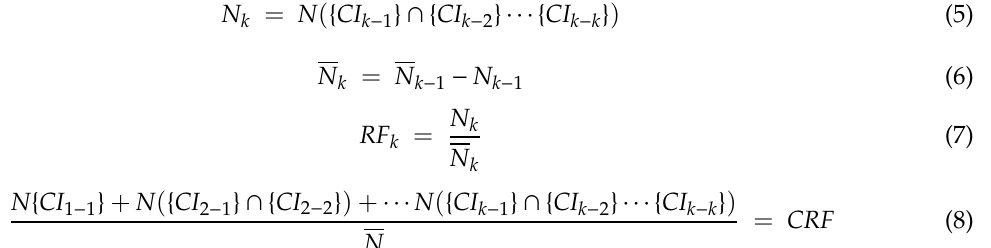
Figure 4. Cumulative probability distribution function of the maximum correlation coefficient.